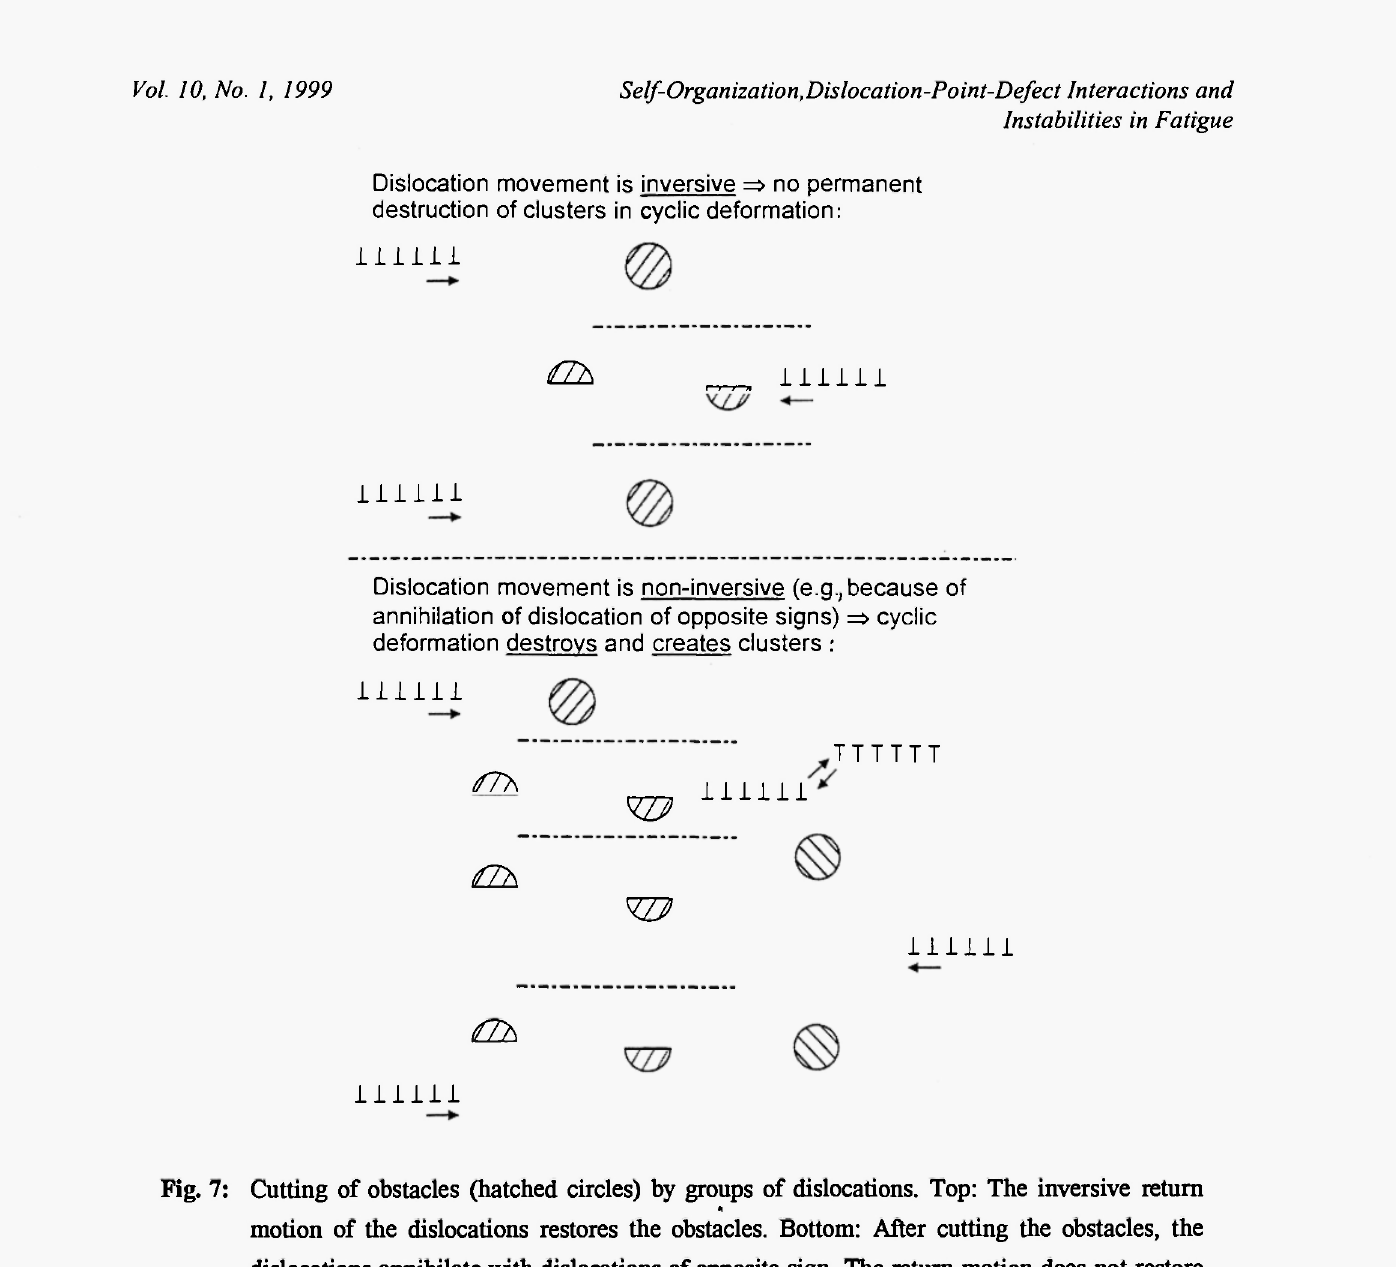
Fig. 7: Cutting of obstacles (hatched circles) by groups of dislocations. Top: The inversive return •ι motion of the dislocations restores the obstacles. Bottom: After cutting the obstacles, the dislocations annihilate with dislocations of opposite sign. The return motion does not restore the original obstacles. The dislocation annihilation has generated new obstacles (indicated by different